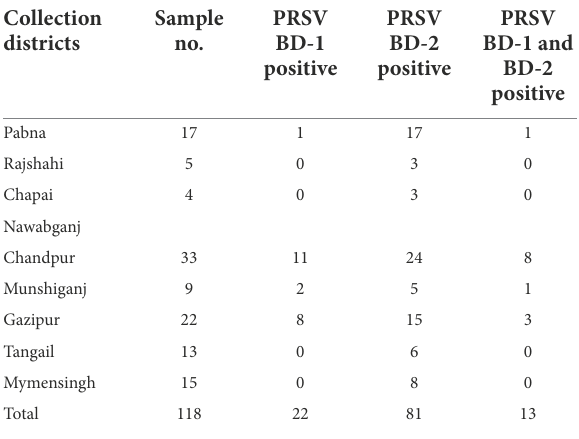
PRSV: Papaya ringspot